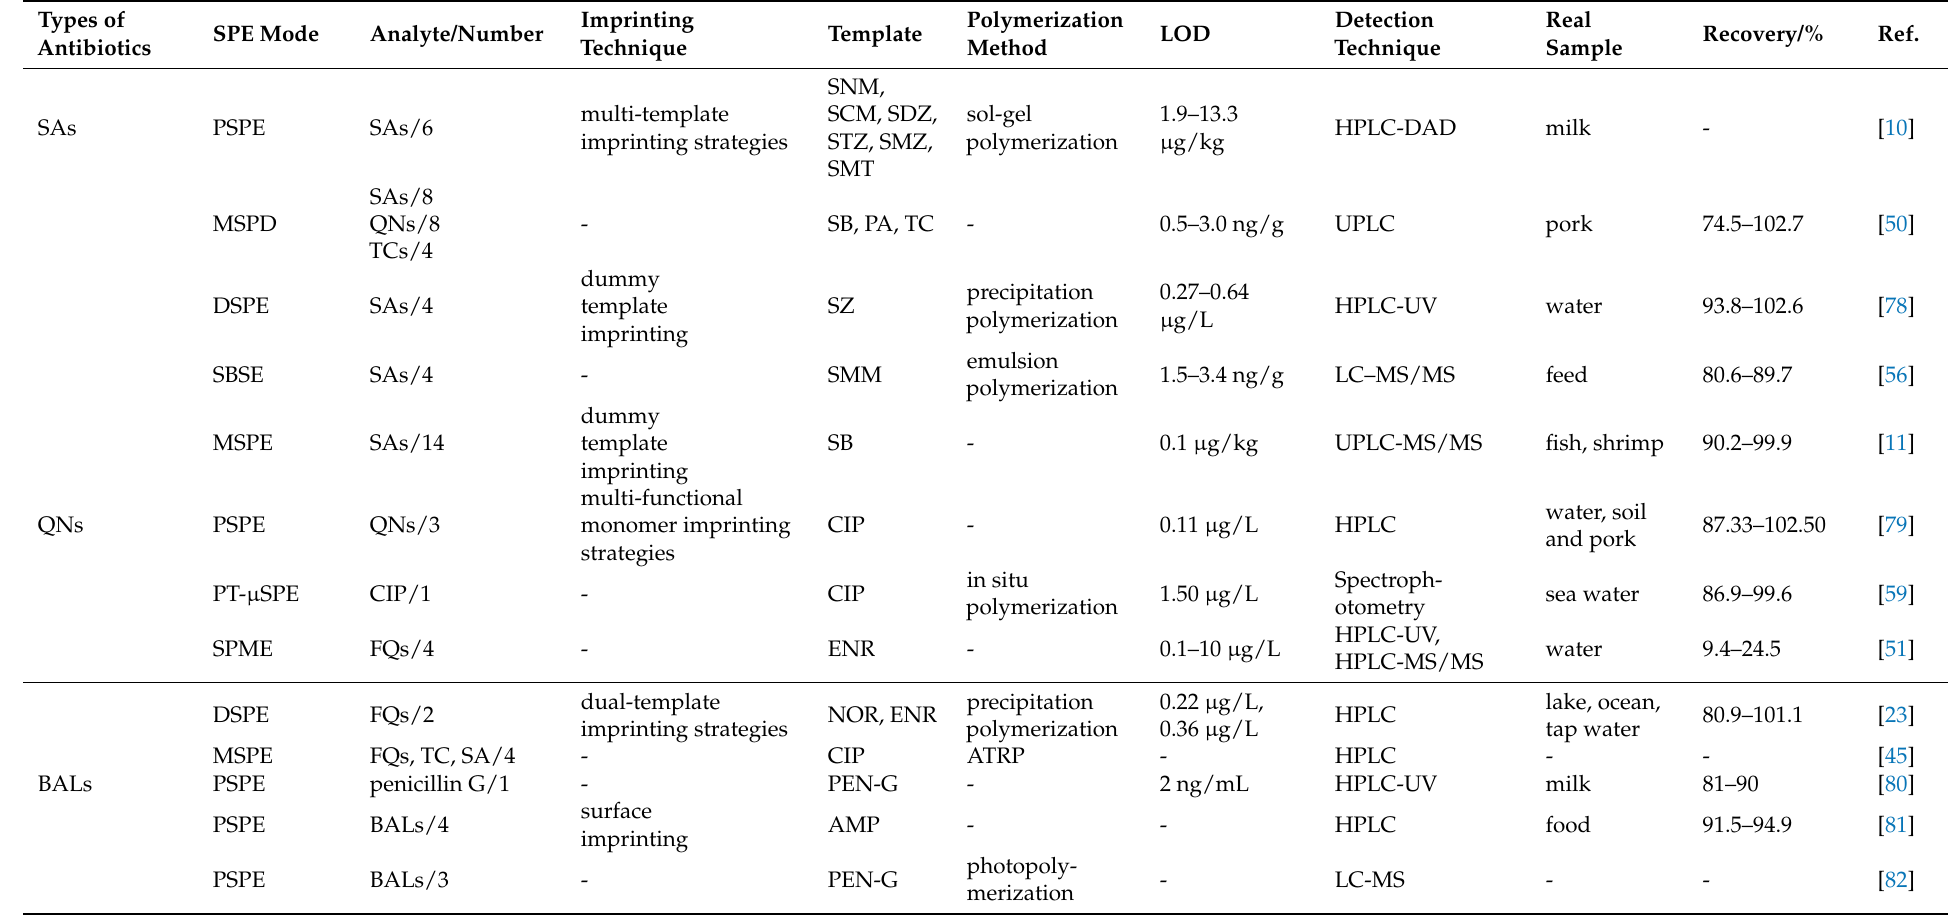
Table 1. Applications of MISPE for antibiotic